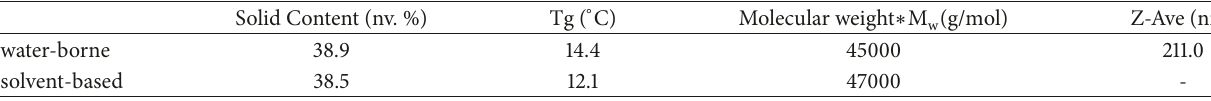
Table 2: Properties of the P(BA/St)